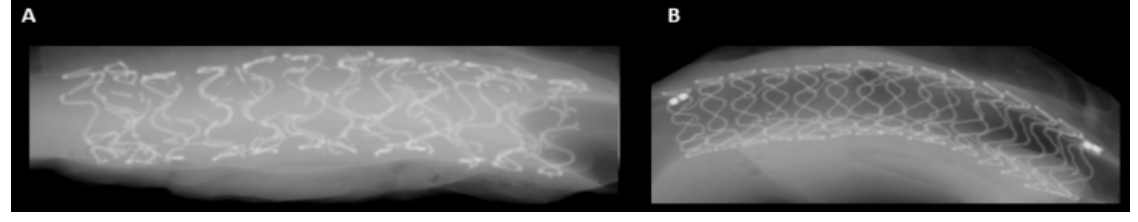
Figure 3. High-resolution faxitron evaluation from a porcine coronary model after 90 days of implantation. At this time point, faster dismantling rate and resorption of the scaffold DREAMS 1G ( A ) than its latest development, the DREAMS 2G ( B ) could be